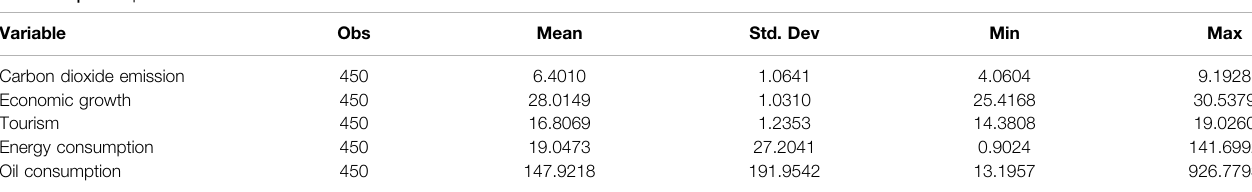
TABLE 2 | Descriptive statistics.